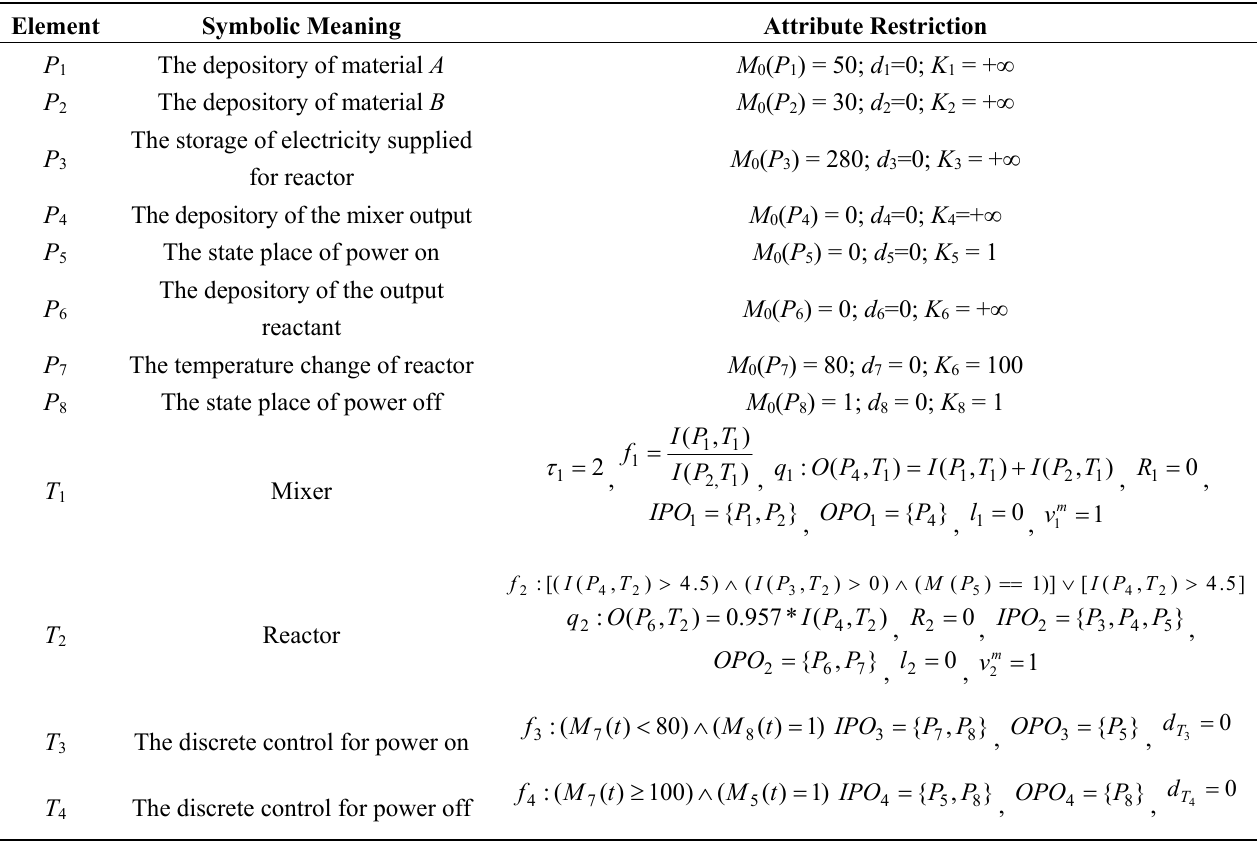
Figure 3. RPM_PIETS model of a chemical reaction process. Table 1. Model elements and attribute